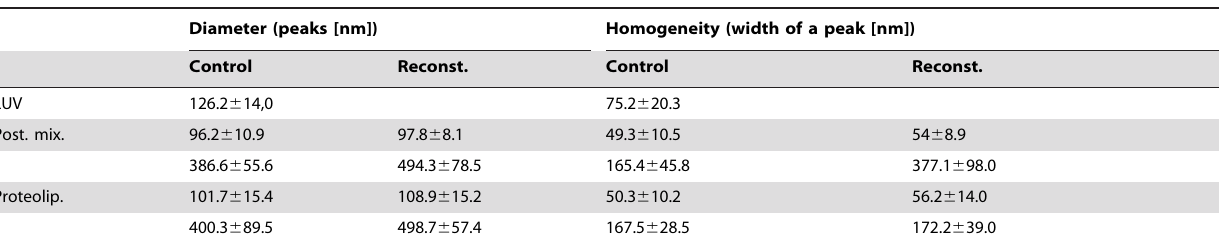
Table 2. Reconstitution of protein using Triton X-100 removed with Bio-Beads.